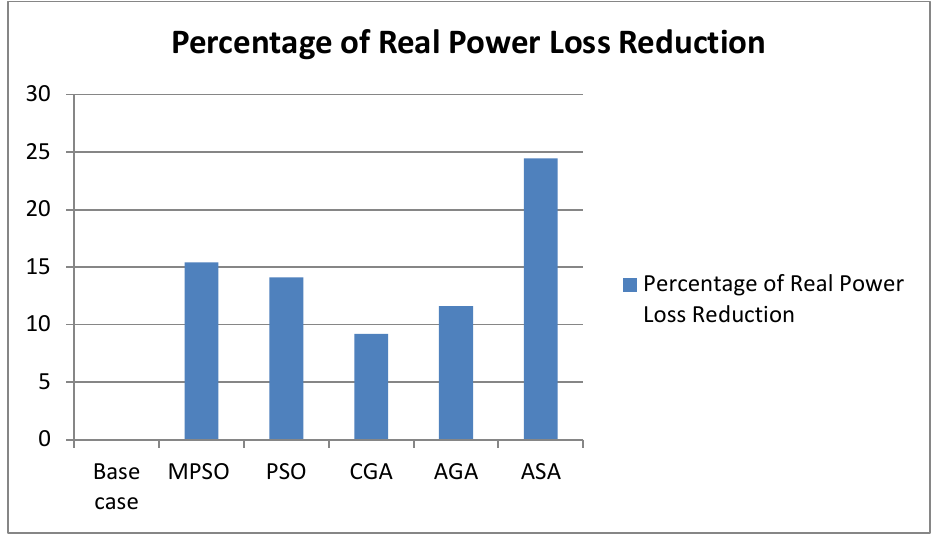
Figure. 1. Comparison of real power loss.